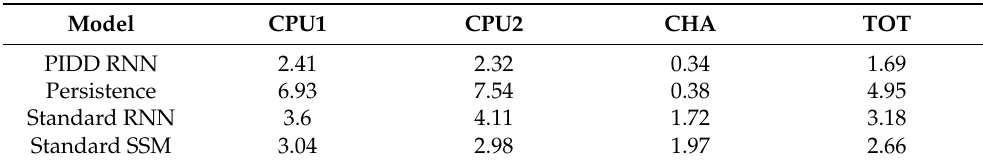
Table 1. RMSE for prediction on the test set (°C) for PIDD RNN model compared with three alternative